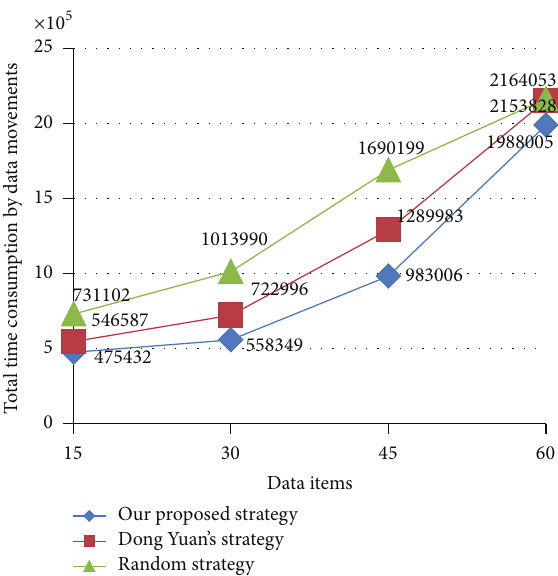
Figure 7: Total time consumed by data movements with 10% fixed- position